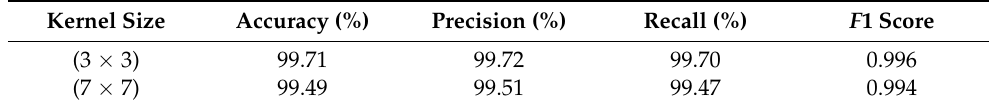
Table 5. Comparison of different convolution kernel sizes.